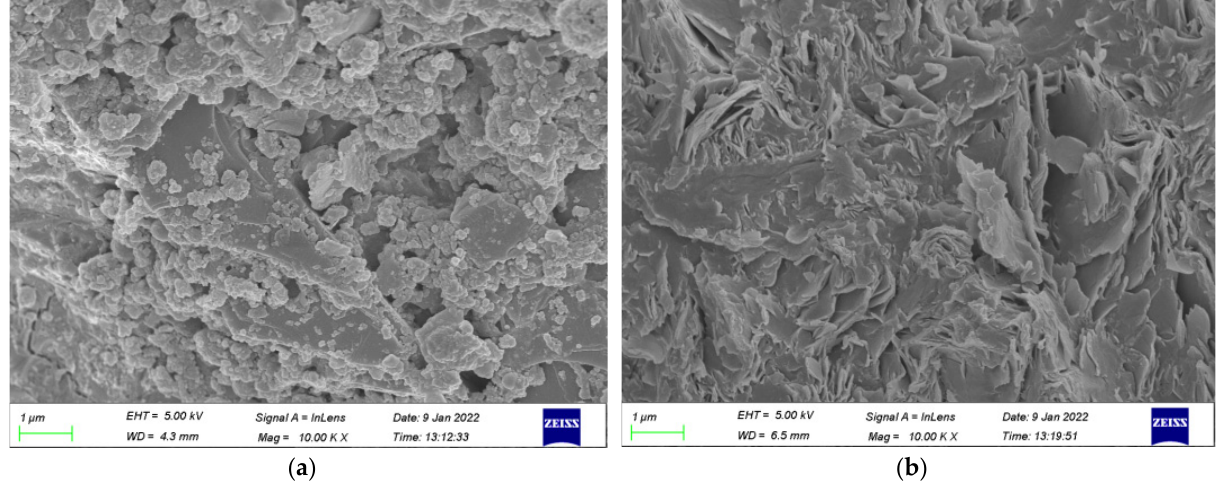
Figure 12. The microstructure of the geopolymer. ( a ) Group C; ( b ) Group N ‐ 1.5.